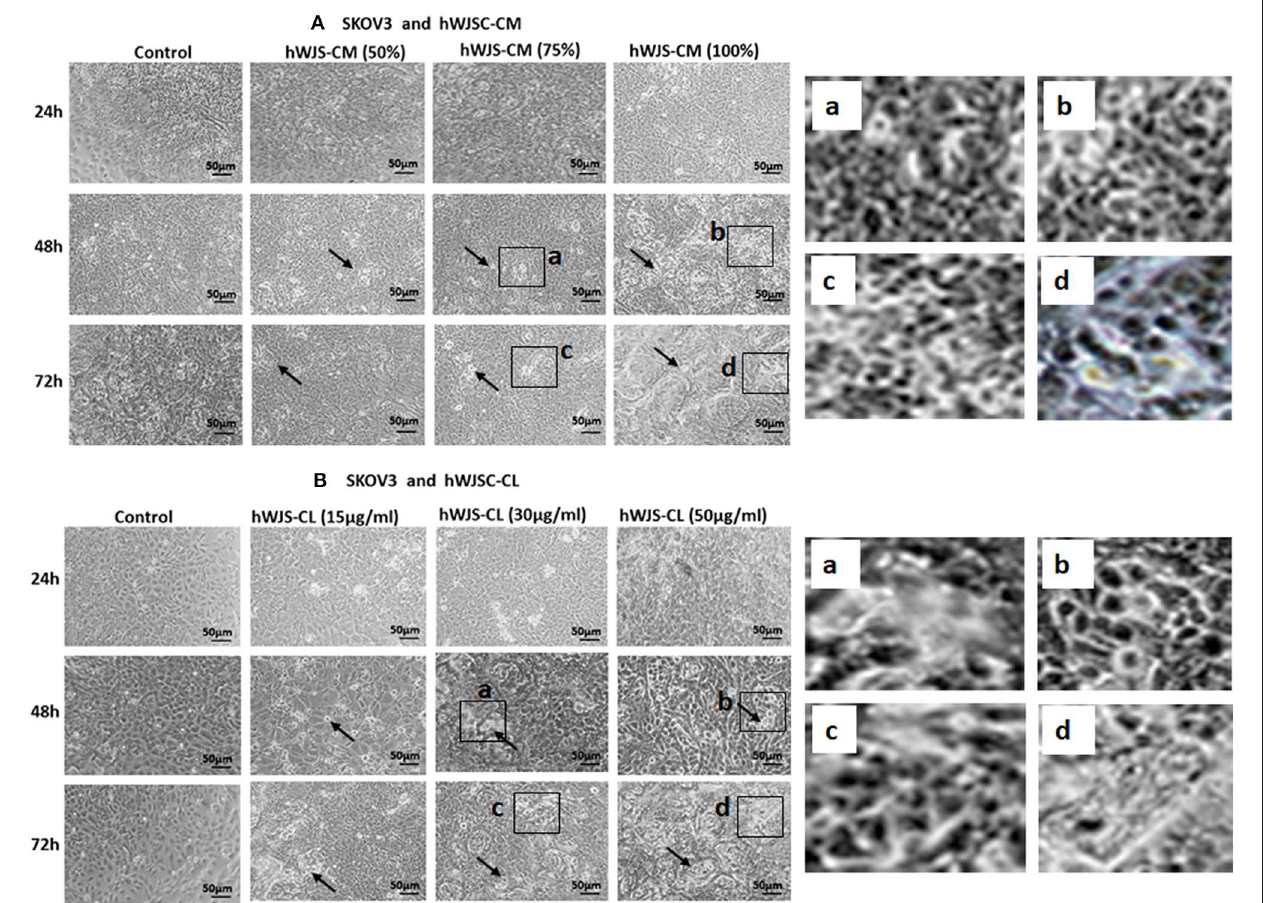
FIGURE 5 | Representative phase contrast images of SKOV3 cells treated with hWJSC-CM (A) and SKOV3 cells treated with hWJSC-CL (B) . There were less cell death and decreases in SKOV3 cells treated with increasing concentrations of hWJSC-CM and hWJSC-CL with time. Thin black arrows indicate dead translucent cells; The magnified images (a–d) represent the respective boxed area (a–d) within the main figure and shows decrease in the size of cells, membrane damages and condensed or fragmented nuclei. hWJSC-CM, human Wharton’s jelly stem cells conditioned medium; hWJSC-CL, human Wharton’s jelly stem cell lysate.